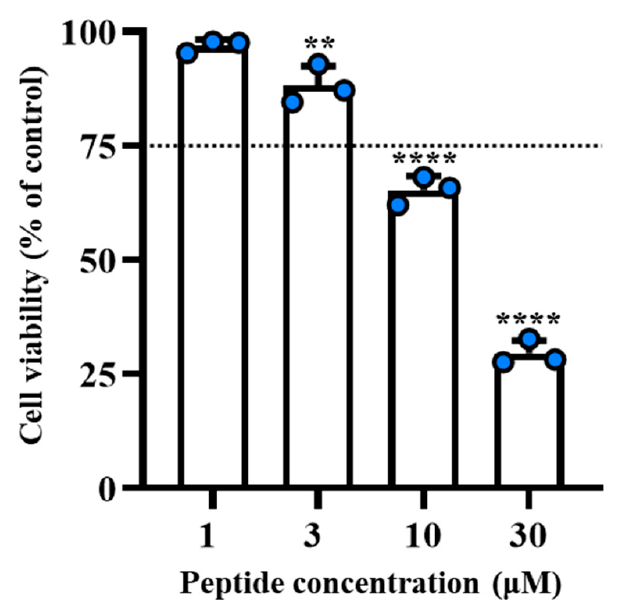
Figure 5. In vitro cytotoxic examination for [Nle 1 , D Leu 9 , D Lys 10 ] at concentrations of 1–30 µ M was performed on J774A.1 murine macrophage cells. Dotted lines indicate the 75% of cell viability. Values are presented as means ± S.D. of 3 independent experiments. ** p ≤ 0.01, **** p < 0.0001 vs. Ctrl group (100%). Statistical analysis was performed by one-way ANOVA followed by Bonferroni’s for multiple comparisons.